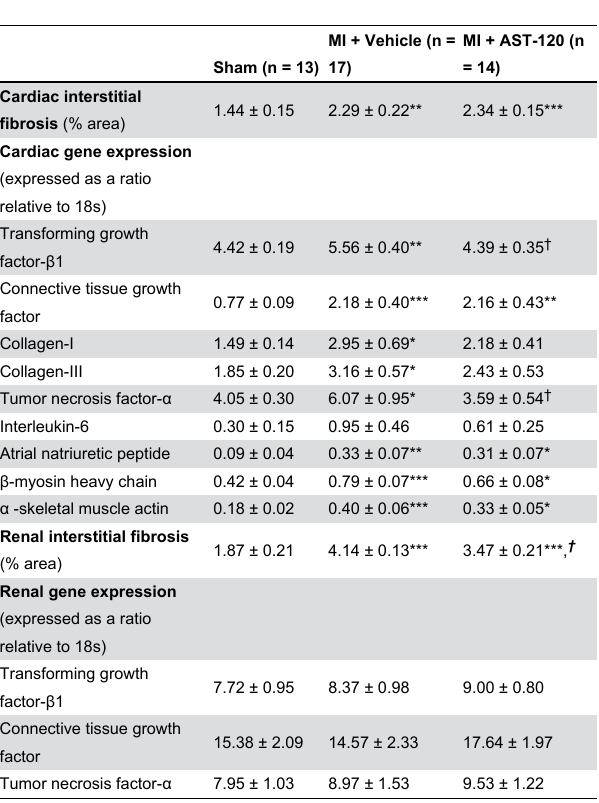
Renal gene expression (expressed as a ratio relative to 18s) Transforming growth factor-β1 Connective tissue growth